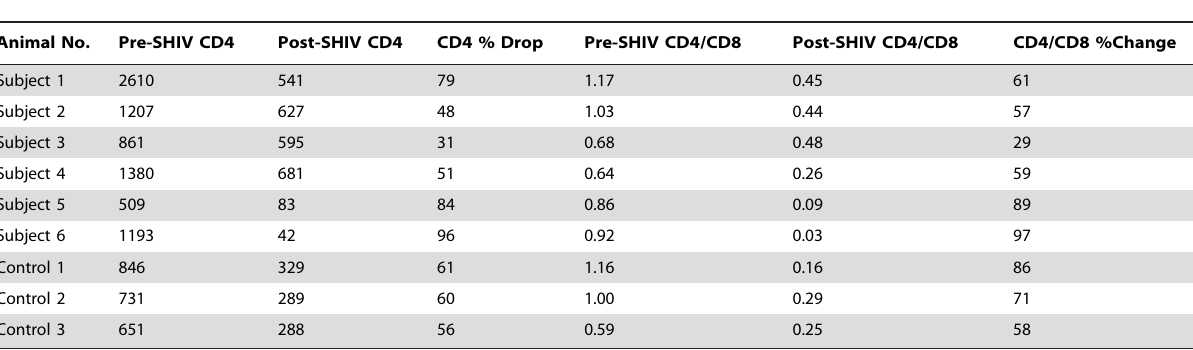
Table 1. Pre-vaccination hematology of SHIV-infected rhesus macaques.